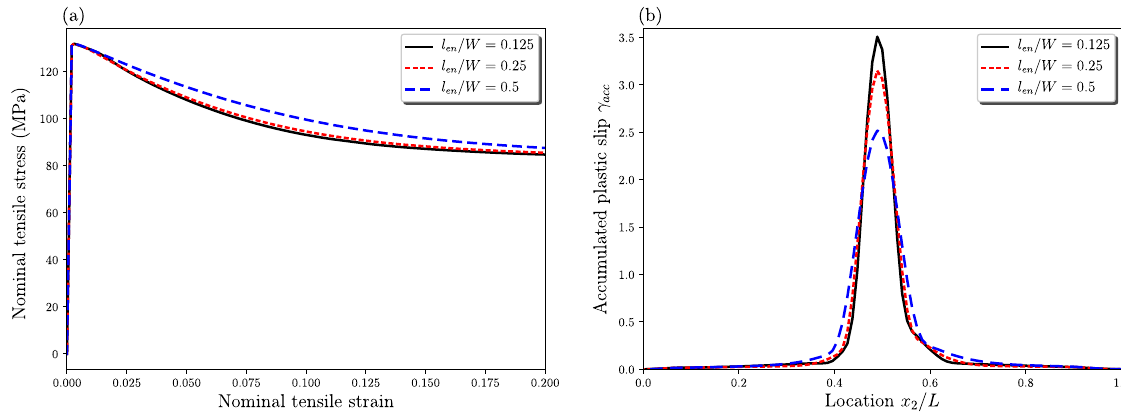
Figure 15. Influence of energetic length scale l en : ( a ) nominal tensile stress–strain curves and ( b ) distribution of plastic slip variable γ along the x 2 direction at ∆ L / L 0 = 0.2 ( l dis =